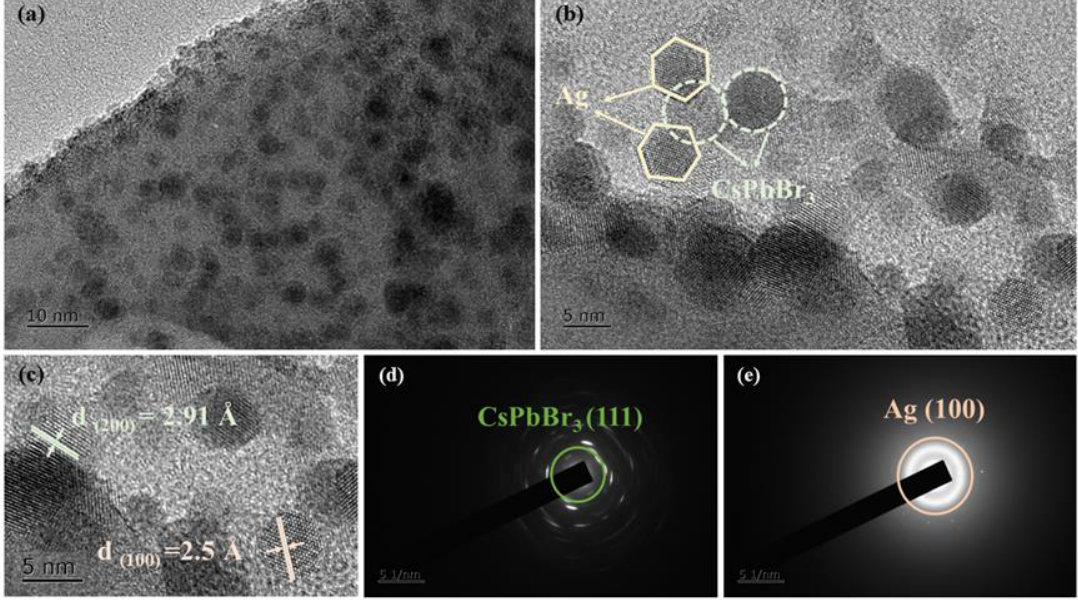
Figure 5. ( a ) TEM image, ( b , c ) HRTEM images, ( d , e ) SAED patterns.